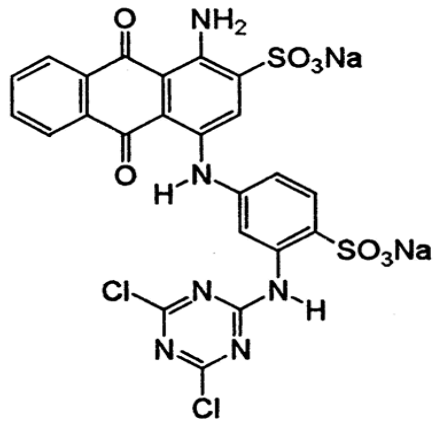
Figure 11. Structure of the RB4 dye .